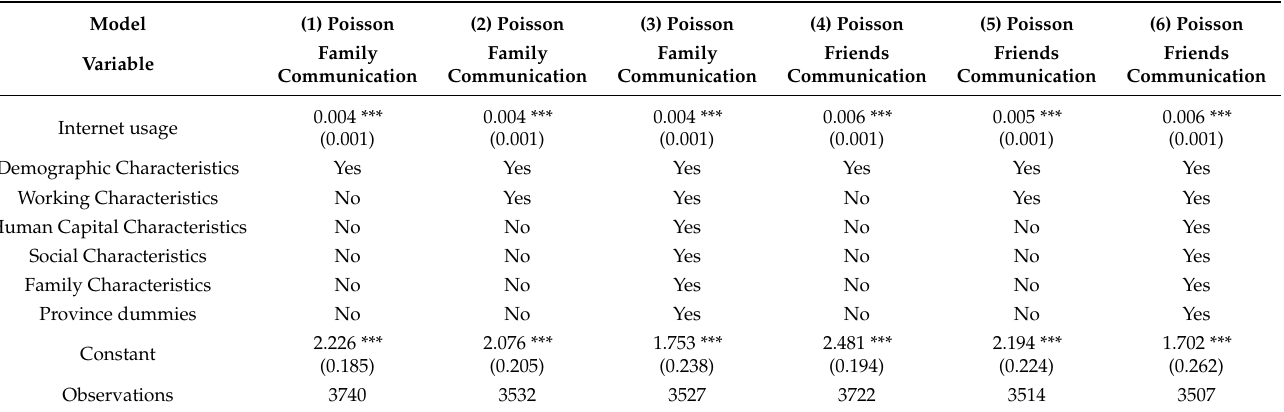
Table 3. Robustness checks using the Poisson model.